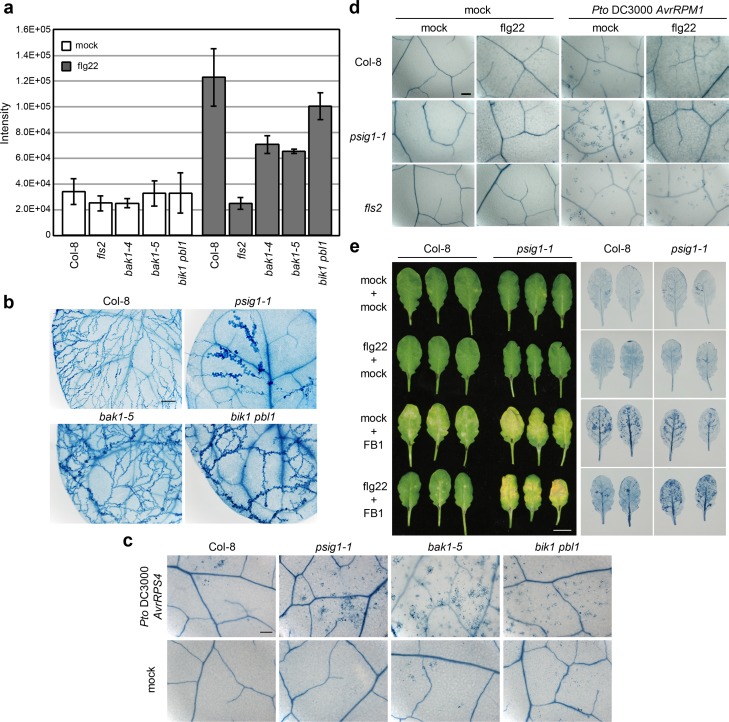
PSIG1 is required for flg22-induced cell death suppression.a, Phosphoregulation of PSIG1 in the PAMP-signaling mutants. Relative abundance of the ‘DIQGSDNAIPLpSPQWLLSKPGENK’ phosphopeptide upon flg22 treatment. Arabidopsis seedlings were treated with 1 μM flg22 for 10 min or received a mock treatment (dH2O) prior to phosphoproteome analysis. Data are shown as the mean ± SD from three independent experiments. b, The bak1-5 and bik1 pbl1 mutants induce cell death upon Hpa Noco2 infection. Plants were inoculated with spores of Hpa Noco2, and dead cells on true leaves were visualized by trypan blue staining 5 days after inoculation. The scale bar represents 200 μm. c, Induction of RPS4-triggered cell death is pronounced in the bak1-5 and bik1 pbl1 mutants. Plants were spray inoculated with 1 x 108 c.f.u. ml-1 of Pto AvrRPS4, and dead cells were visualized by trypan blue staining 2 days after inoculation. The scale bar represents 200 μm. d, Flg22-induced restriction of effector injection by Pto is intact in the psig1-1 mutant. Leaves were infiltrated with 100 nM flg22 or received a mock treatment (dH2O). Twenty-four h after the pretreatments, plants were spray inoculated with 1 x 108 c.f.u. ml-1 of Pto AvrRPM1, and dead cells were visualized by trypan blue staining 24 h after inoculation. The scale bar represents 200 μm. e, Suppression of flg22-induced FB1-triggered cell death is compromised in the psig1-1 mutant. Leaves were infiltrated with FB1 after mock (dH2O) or flg22 pretreatments. Control leaves were infiltrated with dH2O (mock) after mock (dH2O) or flg22 pretreatments. Photographs were taken 4 days after FB1 infiltration. Dead cells were visualized by trypan blue staining. The scale bar represents 200μm.